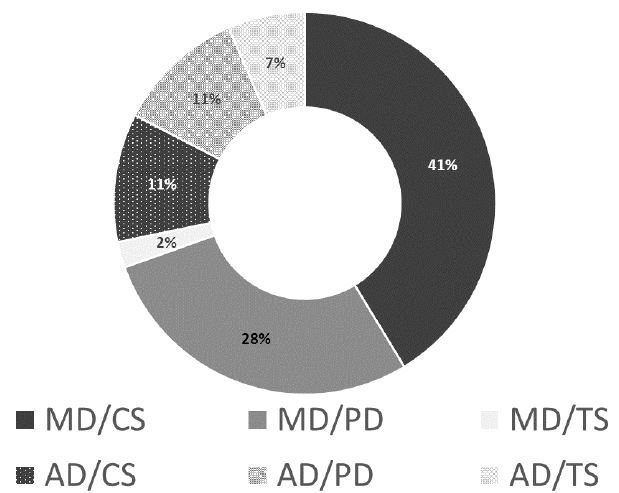
Figure 2. Percentage of studies by type of data. Note: MD, microdata; AD, aggregated data; CS, cross-section; PD, panel data; TS, time series.